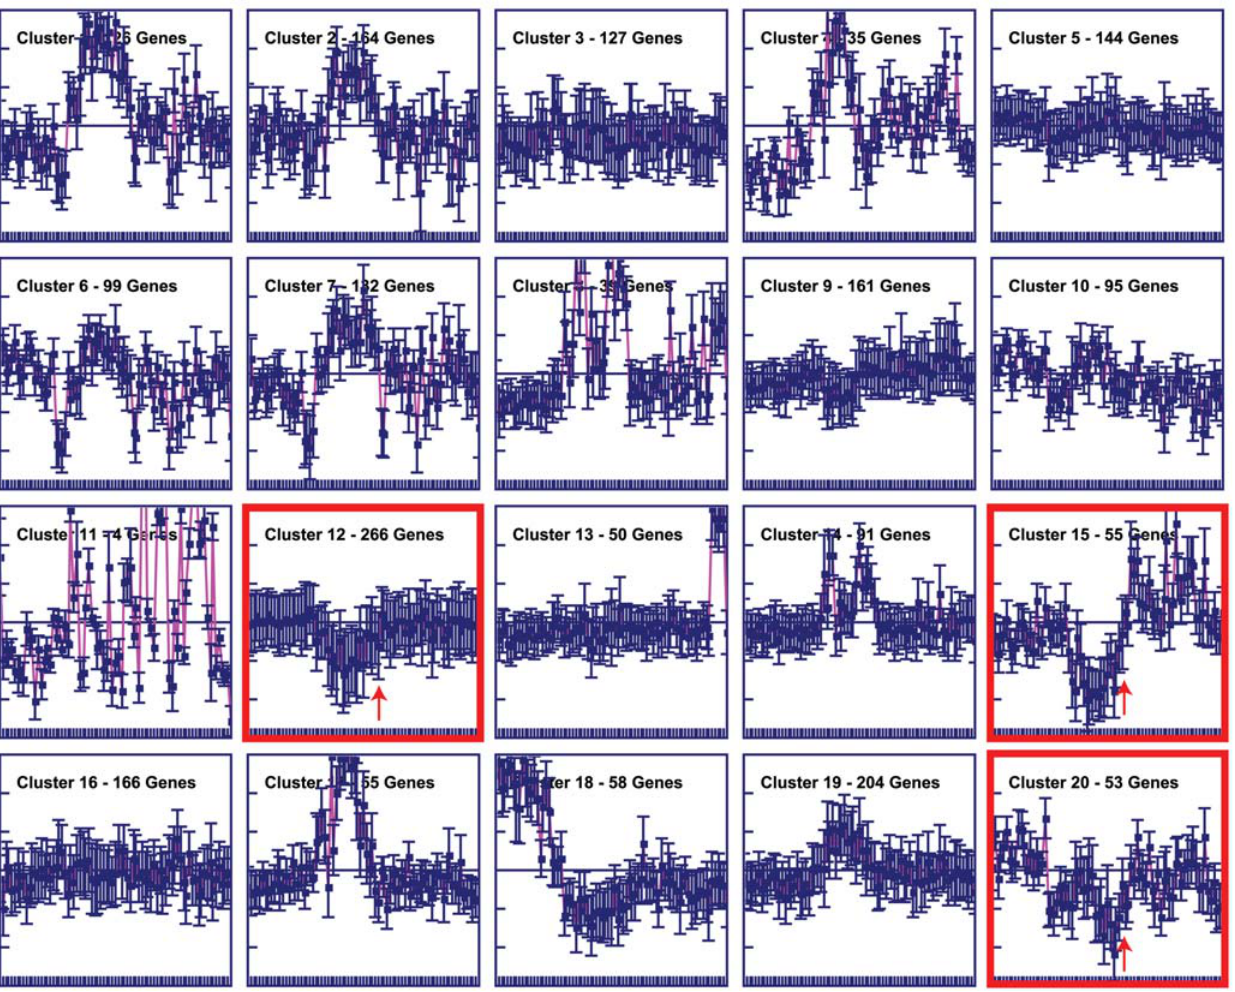
Figure 6. Coexpressed clusters of putative hsa-mir-548 target genes. Centroid views with average tissue-specific expression values are shown for all 20 clusters. Clusters containing genes down-regulated in the colorectal adenocarcinoma sample are shown in red and arrows indicate the colorectal sample.